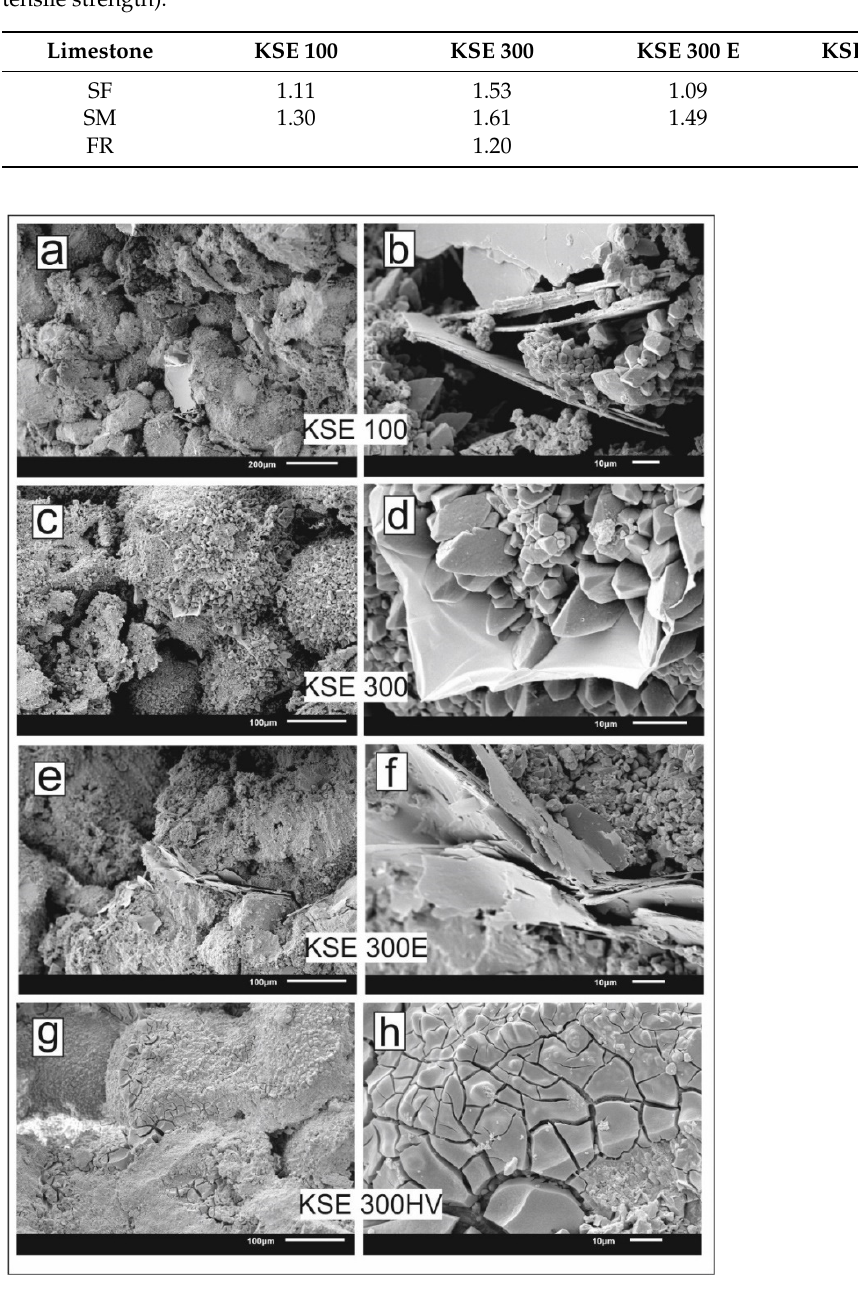
Figure 8. Scanning electron microscopic images of consolidated samples of SM. ( a , b ) thin plates of KSE 100 partly filling pores; ( c , d ) pore filling thicker forms of solid silica gel of KSE 300; ( e , f ) thin curved flakes of KSE 300 E forming elastic bonds between carbonate particles; ( g , h ) pore filling but not pore occluding consolidant of KSE 300 HV with micro-cracks.